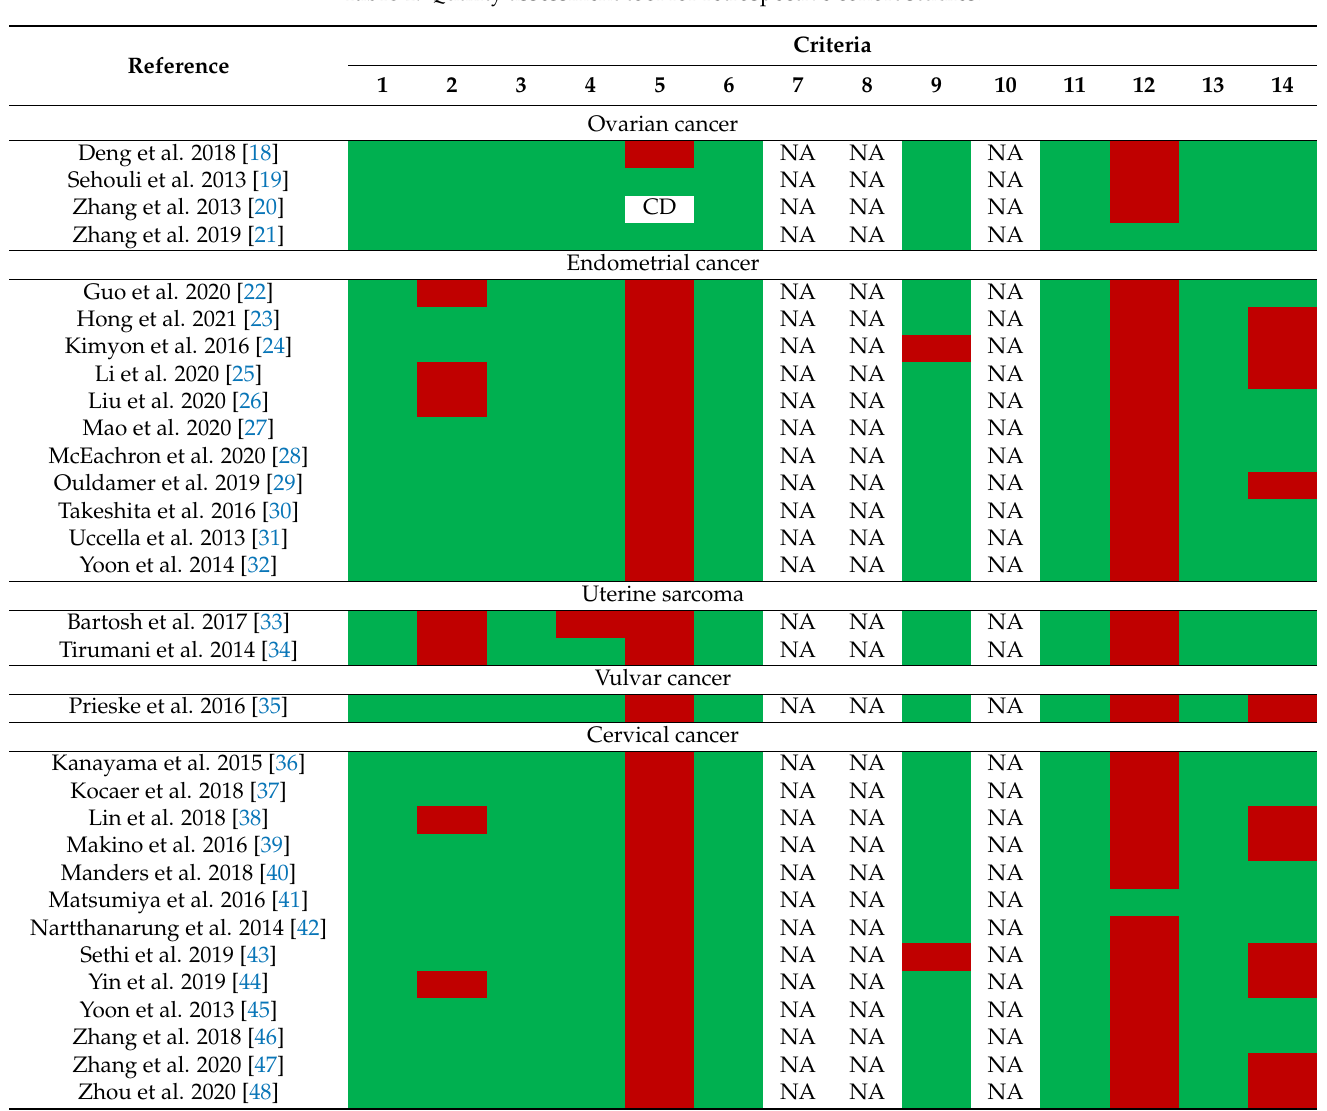
Table 1. Quality assessment tool for retrospective cohort